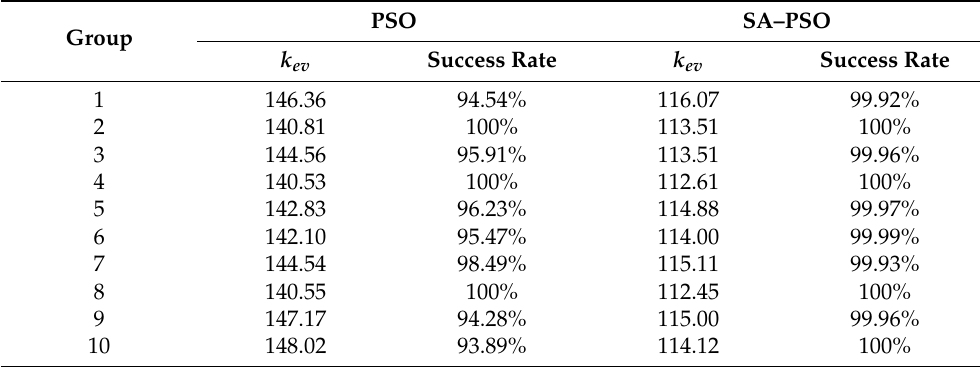
Table 5. The average number of iterations and success rate.